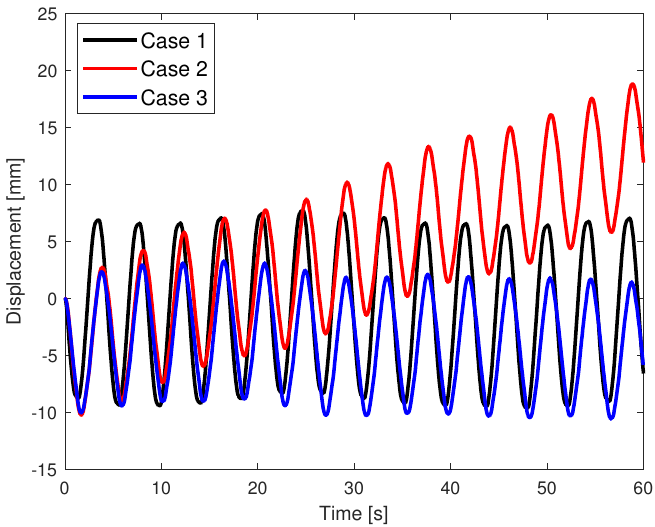
Figure 3. The displacement of the robot when the arms move synchronously (Case 1), asynchronously with distinct median angles (Case 2), and asynchronously with same median angles (Case